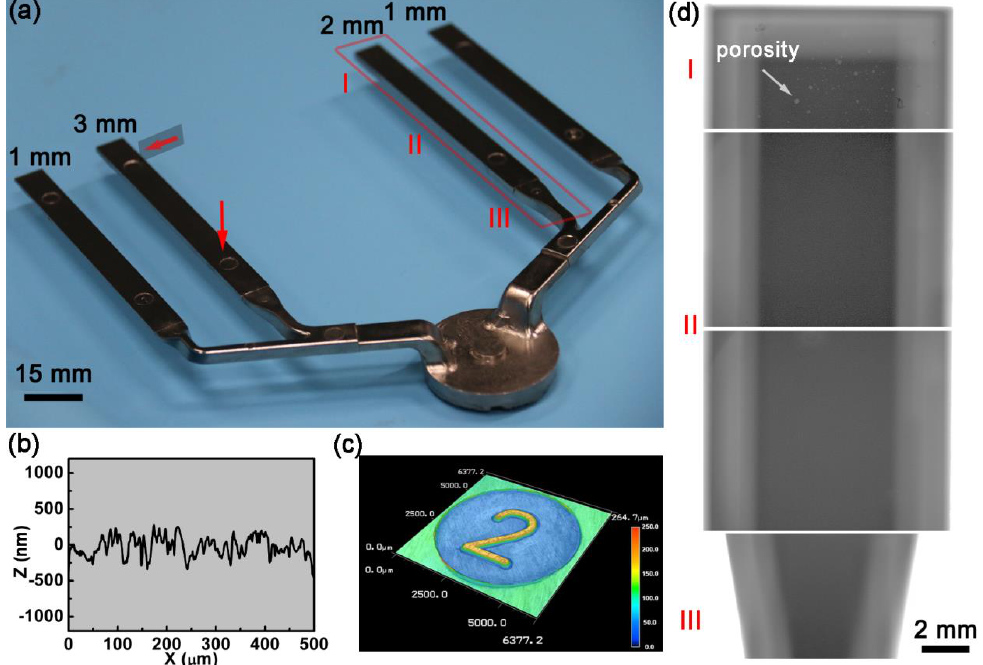
Figure 3. ( a ) Image of BMG sample (Zr 55 Cu 30 Ni 5 Al 10 , Zr55) fabricated by the EPV-HPDC process. The red arrow indicates from where the samples were taken for X-ray diffraction, and the DSC measurements. All of the breadths of the plates are 10 mm; ( b ) Profilogram of surface of casting; ( c ) detail of a miniature embossing character in the surface of casting; ( d ) X-ray images from the representative regions of casting in ( a ).